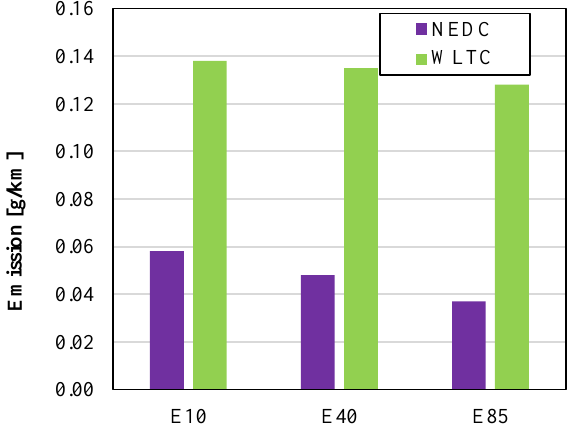
Fig. 4. NO x emission values from a vehicle with a SI engine powered by E10, E40 and E85 fuel in the NEDC and WLTC test